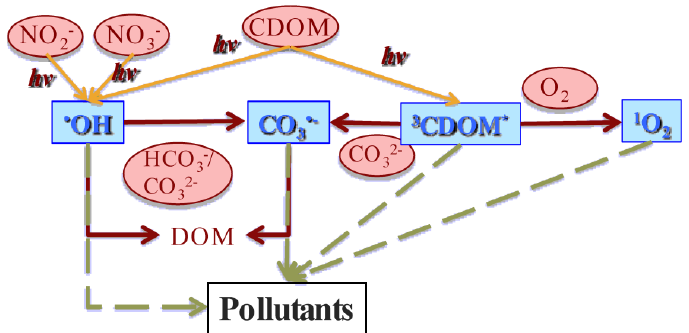
Figure 1. Schematic of the main processes involving photochemical production and scaveng- ing/quenching of the main PPRIs ( • OH, CO 3 •− , 3 CDOM*, and 1 O 2 ) in natural surface waters. DOM = dissolved organic matter; CDOM = chromophoric dissolved organic matter. Circles: photosensi- tizers and scavengers/quenchers; rectangles: PPRIs.